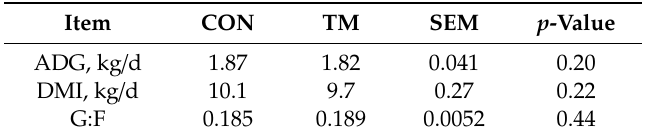
Table 3. E ff ects of maternal supplementation of trace minerals on the finishing performance of subsequent steer progeny during the finishing phase.